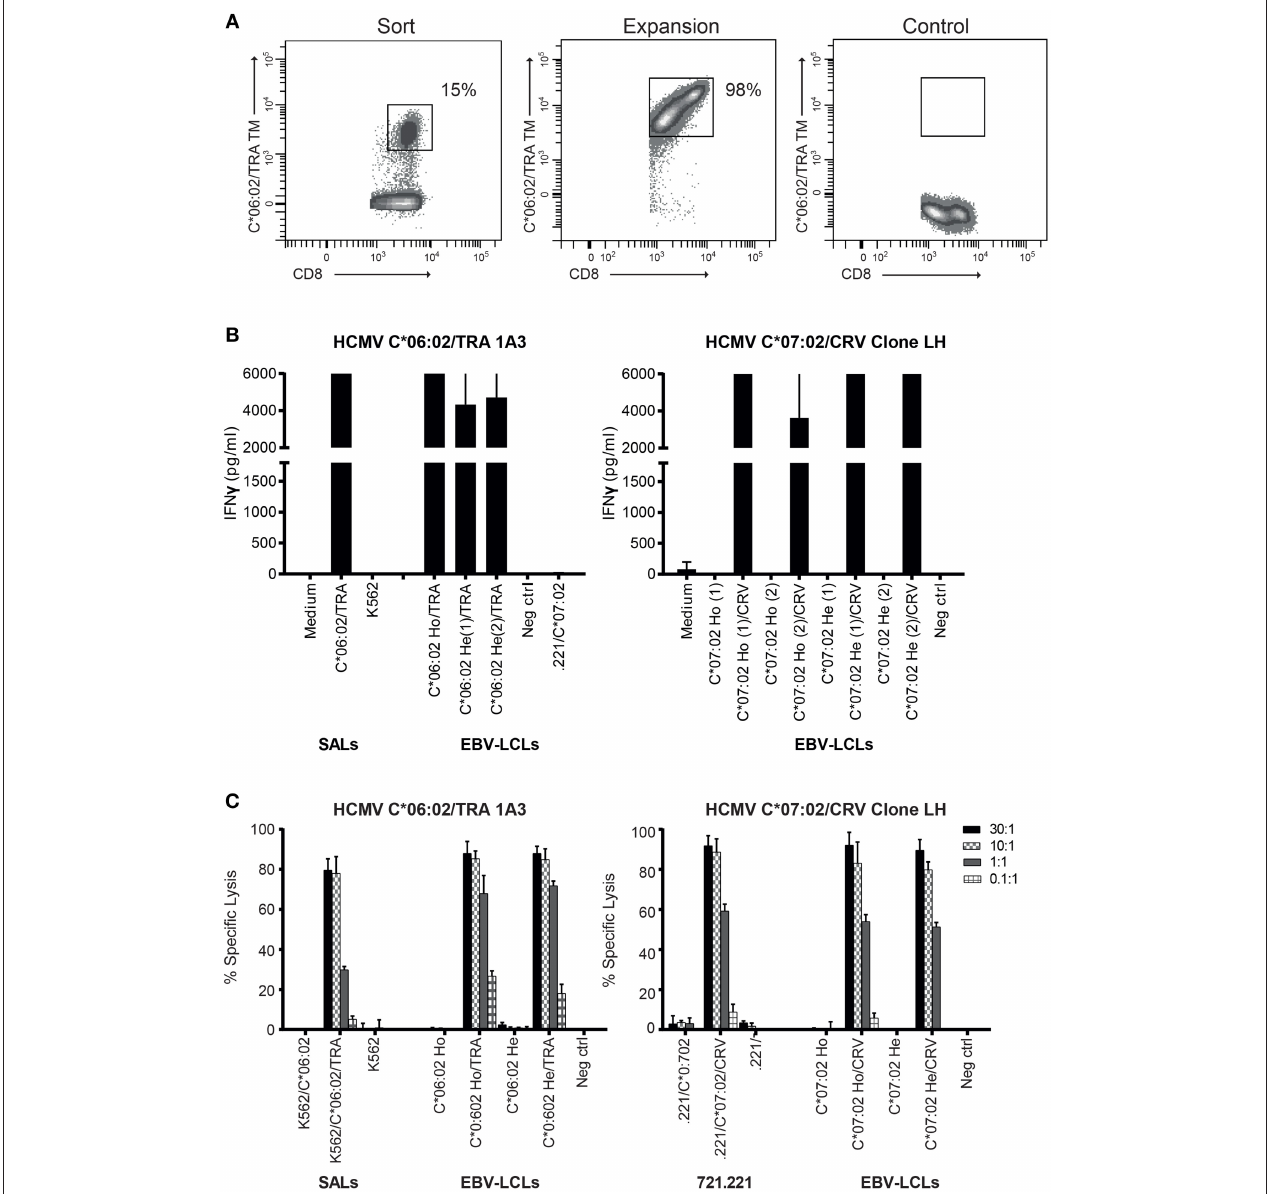
FIGURE 3 | Generated HCMV HLA-C*06:02/TRA T cell lines and clones, and the HCMV HLA-C*07:02/CRV T cell clone are cytolytic against their target cells. (A) FACS plots of HLA-C*06:02/TRA tetramer staining at time of sorting and 2 weeks after expansion of the tetramer-positive CD8 + T cells. (B) Two HCMV C*06:02/TRA T cell lines (1A3 shown) and two T cell clones, and HCMV C*07:02/CRV T cell clone LH were stimulated with SALs and EBV-LCLs expressing HLA-C*06:02 or C*07:02 loaded with viral peptide. (C) Cytotoxicity of one HCMV C*06:02/TRA T cell line (1A3 shown) and two T cell clones, and HCMV C*07:02/CRV T cell clone LH was tested against 51 Cr-labeled SALs, 721.221 cells and EBV-LCLs expressing the virus-specific restriction HLA allele alone or loaded with viral peptide. The range of the ELISA standard curve: 5–5120 pg/ml. Ho, homozygous; He, heterozygous. Bars represent triplicate values with standard deviation of the mean.